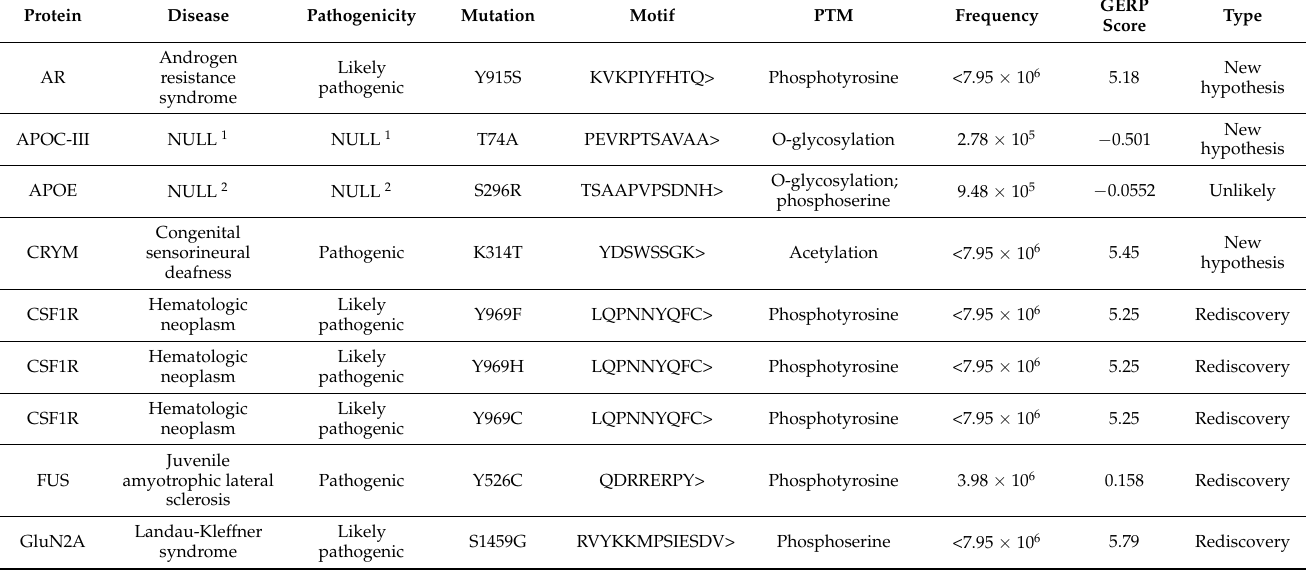
Table 3. Variants discovered in our bioinformatics